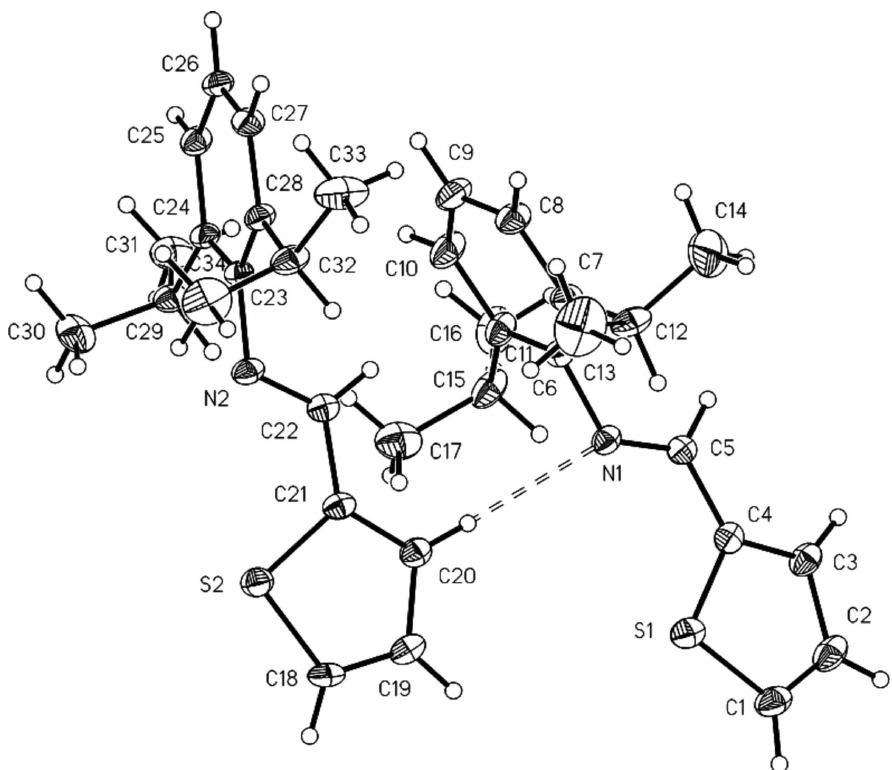
The molecular structure of the title compound, presenting the labelling scheme and 30% probability displacement ellipsoids for non-H